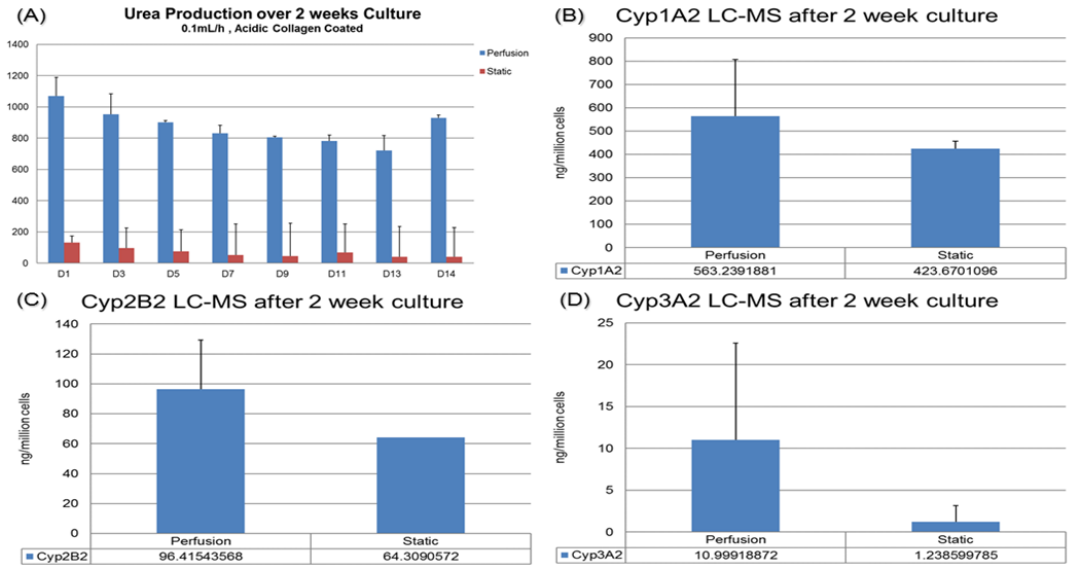
Figure 6. Hepatic function assays targeting drug testing application: ( A ) Urea production over 2 weeks. ( B – D ) Basic CYP level tested via LC-MC. Cells were harvested after 14-day culture: ( B ) CYP1A2. ( C ) CYP2B2. ( D ) CYP3A2.